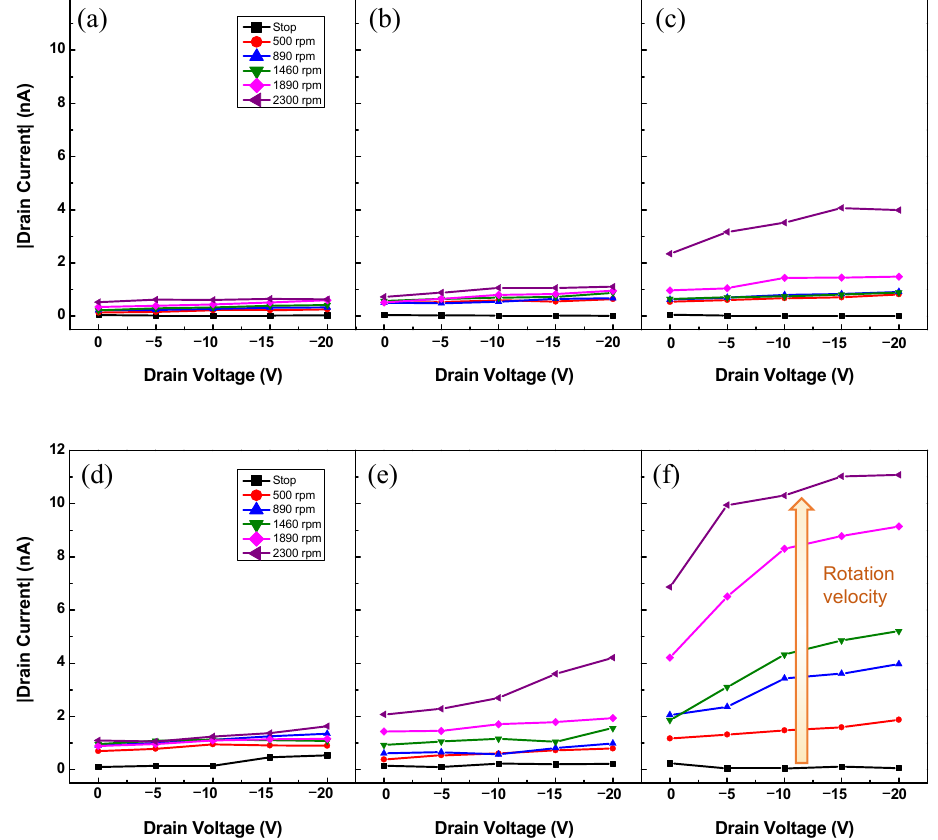
Figure 3. Output characteristics of the fabricated RGTs with active layers deposited by ( a – c ) spin- coating and ( d – f ) drop-casting. The dielectric layer thickness of each device in ( a , d ); ( b , e ); and ( c , f ) was 0.3, 0.5, and 0.8 mm, respectively.